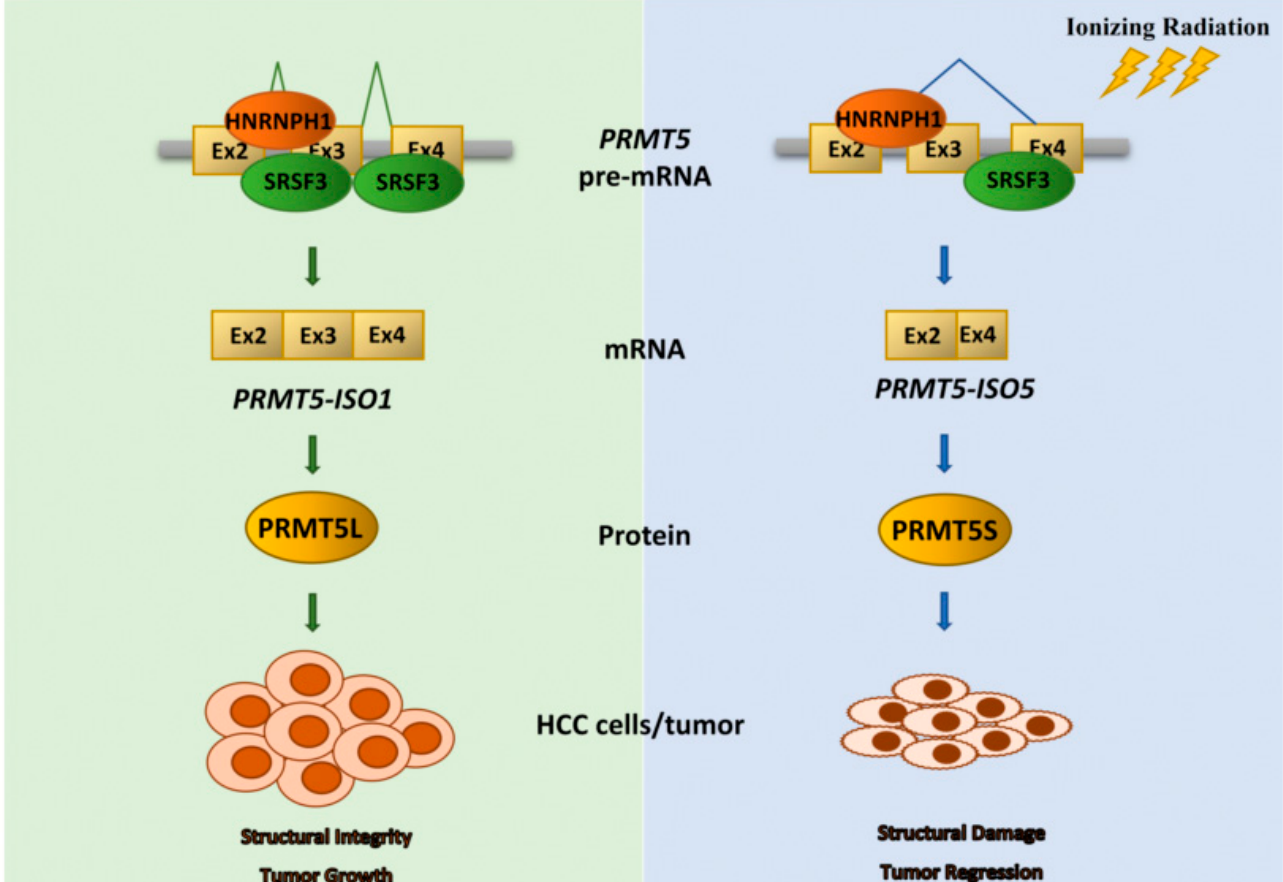
Figure 7. A schematic diagram illustrating SRSF3 downregulation regulates the increase in PRMT5- ISO5 and plays a positive role in radiotherapy of HCC. Normally, canonical PRMT5-ISO1 is the main isoform that translates into full-length PRMT5 (PRMT5L) and promotes HCC development ( left ). After IR treatment, SRSF3 (S3) downregulation breaks its balance with HNRNPH1 (H1) in binding to PRMT5 pre-mRNA and generates PRMT5-ISO5 . The increased PRMT5-ISO5 translates into short-length protein (PRMT5S), which enhances cell radiosensitivity and promotes tumor regression of HCC ( right ).